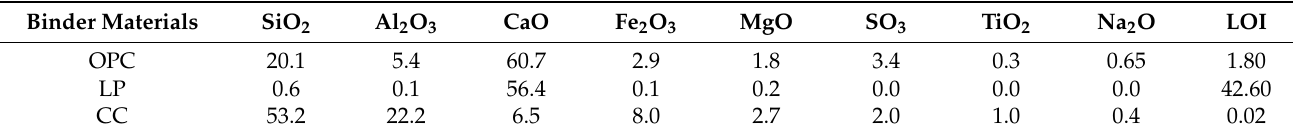
Table 1. Oxide compositions of OPC, LP and CC (wt.%).